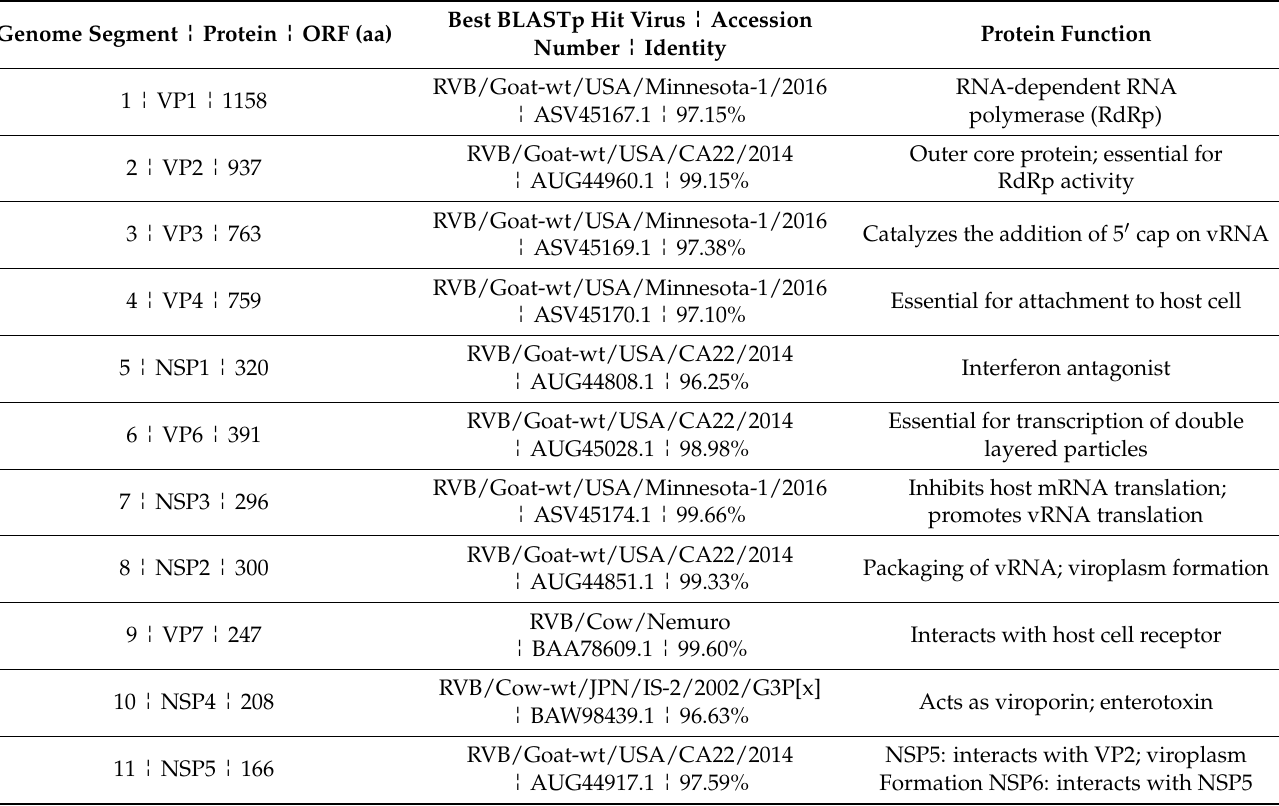
Table 2. BLASTp analysis of the eleven putative open reading frames of RVB/Horse-wt/USA/KY1518/2021. Genome Segment ¦ Protein ¦ ORF